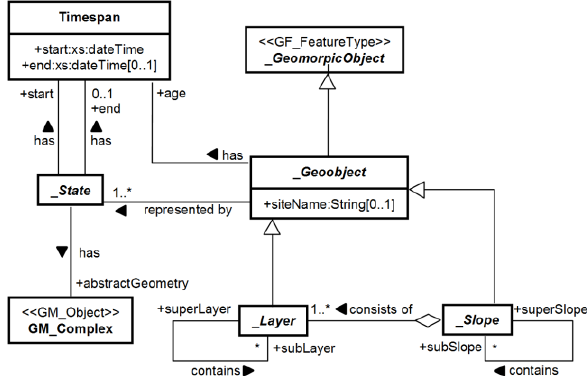
Figure 1. The abstract class _Geoobject represented by a time- dependent geometry and attributes (not depicted here) (Löwner, 2008,